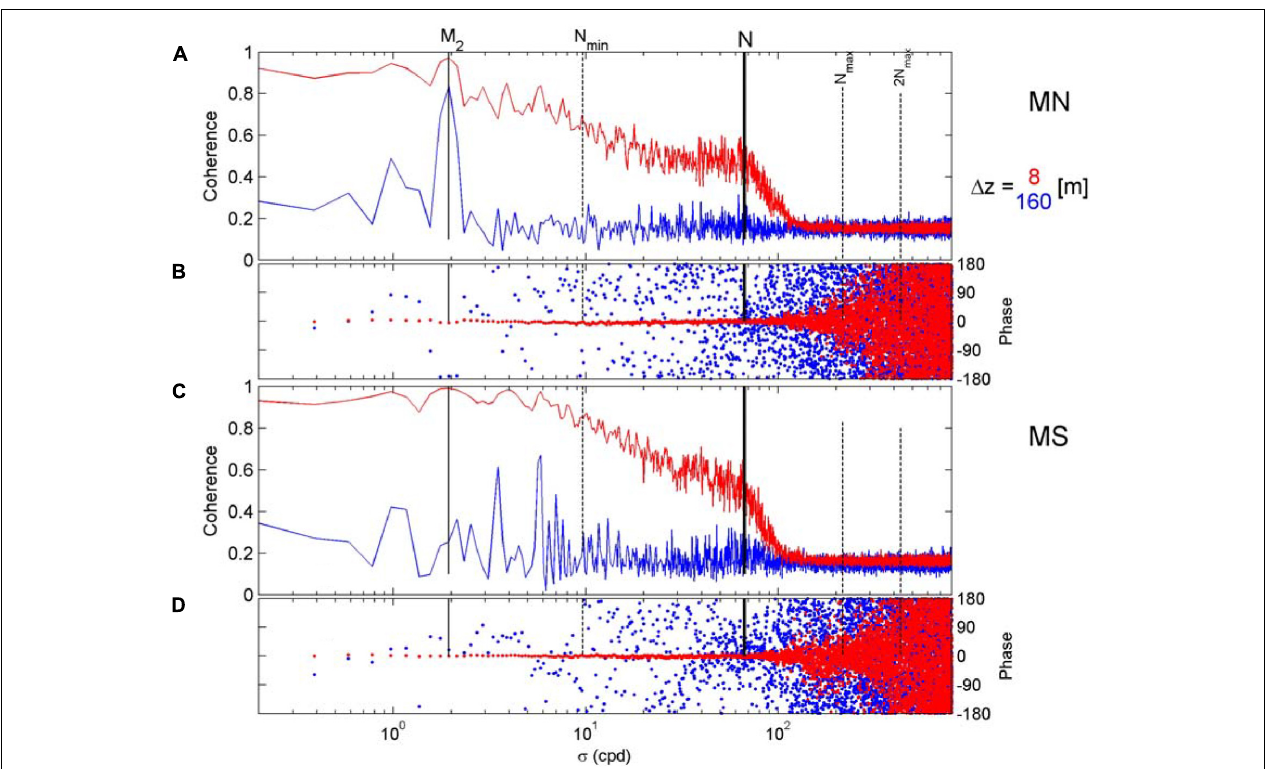
FIGURE 6 | Strongly smoothed ( ∼ 400 degrees of freedom ‘dof’) three-week mean cross-spectral coherence and phase between all possible non-overlapping pairs of T-sensors vertically separated by 8 m (red) and 160 m (blue). The focus is on the [f, N] range, with particular frequencies indicated. N min indicates the overall minimum buoyancy frequency, N max indicates the maximum small-, 2 m, scale buoyancy frequency. (A) MN coherence ‘coh-lev’. The 95% significance level coh-lev ≈ 0.19. (B) MN phase, with relevant values only for coh-lev > 0.19. (C) MS coherence. (D) MS